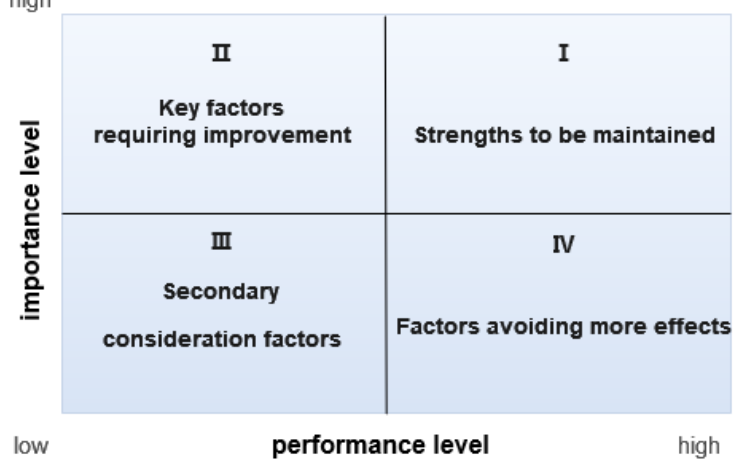
Figure 4. Schematic of the importance-performance analysis.